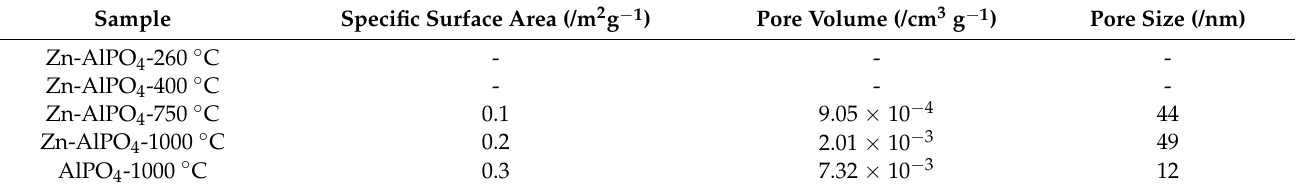
Table 1 lists data on the textural properties of the samples thermally treated at different temperatures, as determined by N 2 adsorption/desorption isotherms [27]. Table 1. Textural properties of the samples heat-treated at different